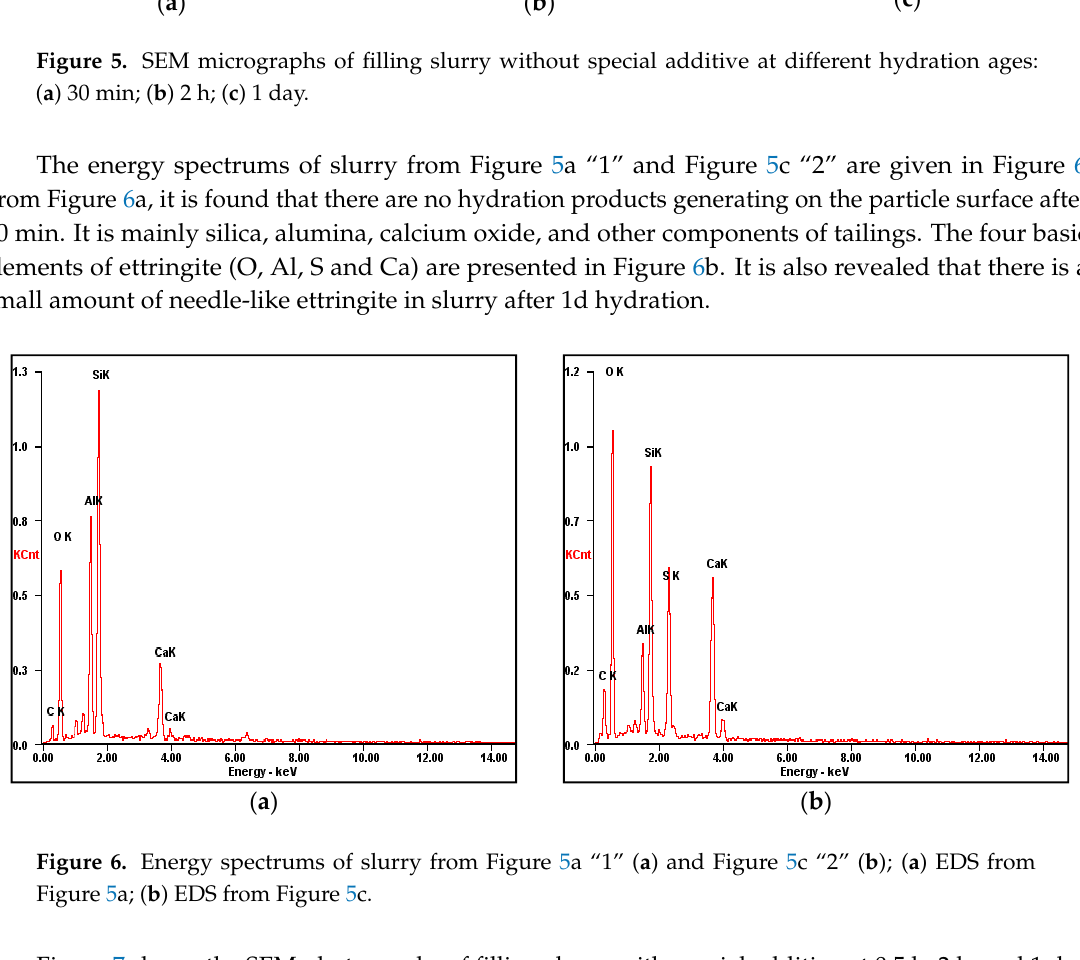
Figure 5. SEM micrographs of filling slurry without special additive at different hydration ages: ( a ) 30 min; ( b ) 2 h; ( c ) 1 day.